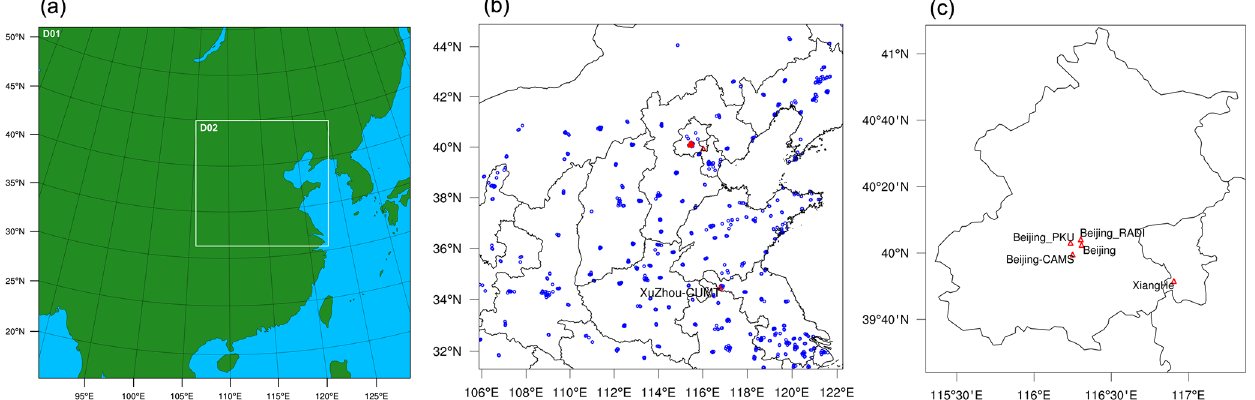
Figure 1. Configuration of the two-level nested domain used in this study (a) , the monitoring stations in Domain 2 (D02) (b) , and a zoomed- in map for AERONET sites in Beijing area (c) , including Beijing, Beijing-CAMS, Beijing_PKU, Beijing_RADI, and XiangHe. There are a total of 683 surface ambient air quality monitoring stations represented by little blue circles, which are mainly located in urban areas, as well as six AERONET sites represented by red triangles in D02. All the maps are plotted with NCAR Command Language Version